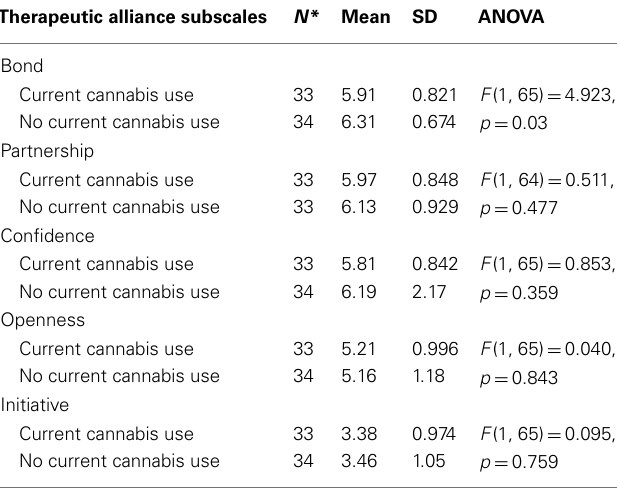
Table 2 | Current cannabis # users compared to no current cannabis users on client-rated subscales of theAgnew-Davies Relationship Measure of therapeutic alliance.